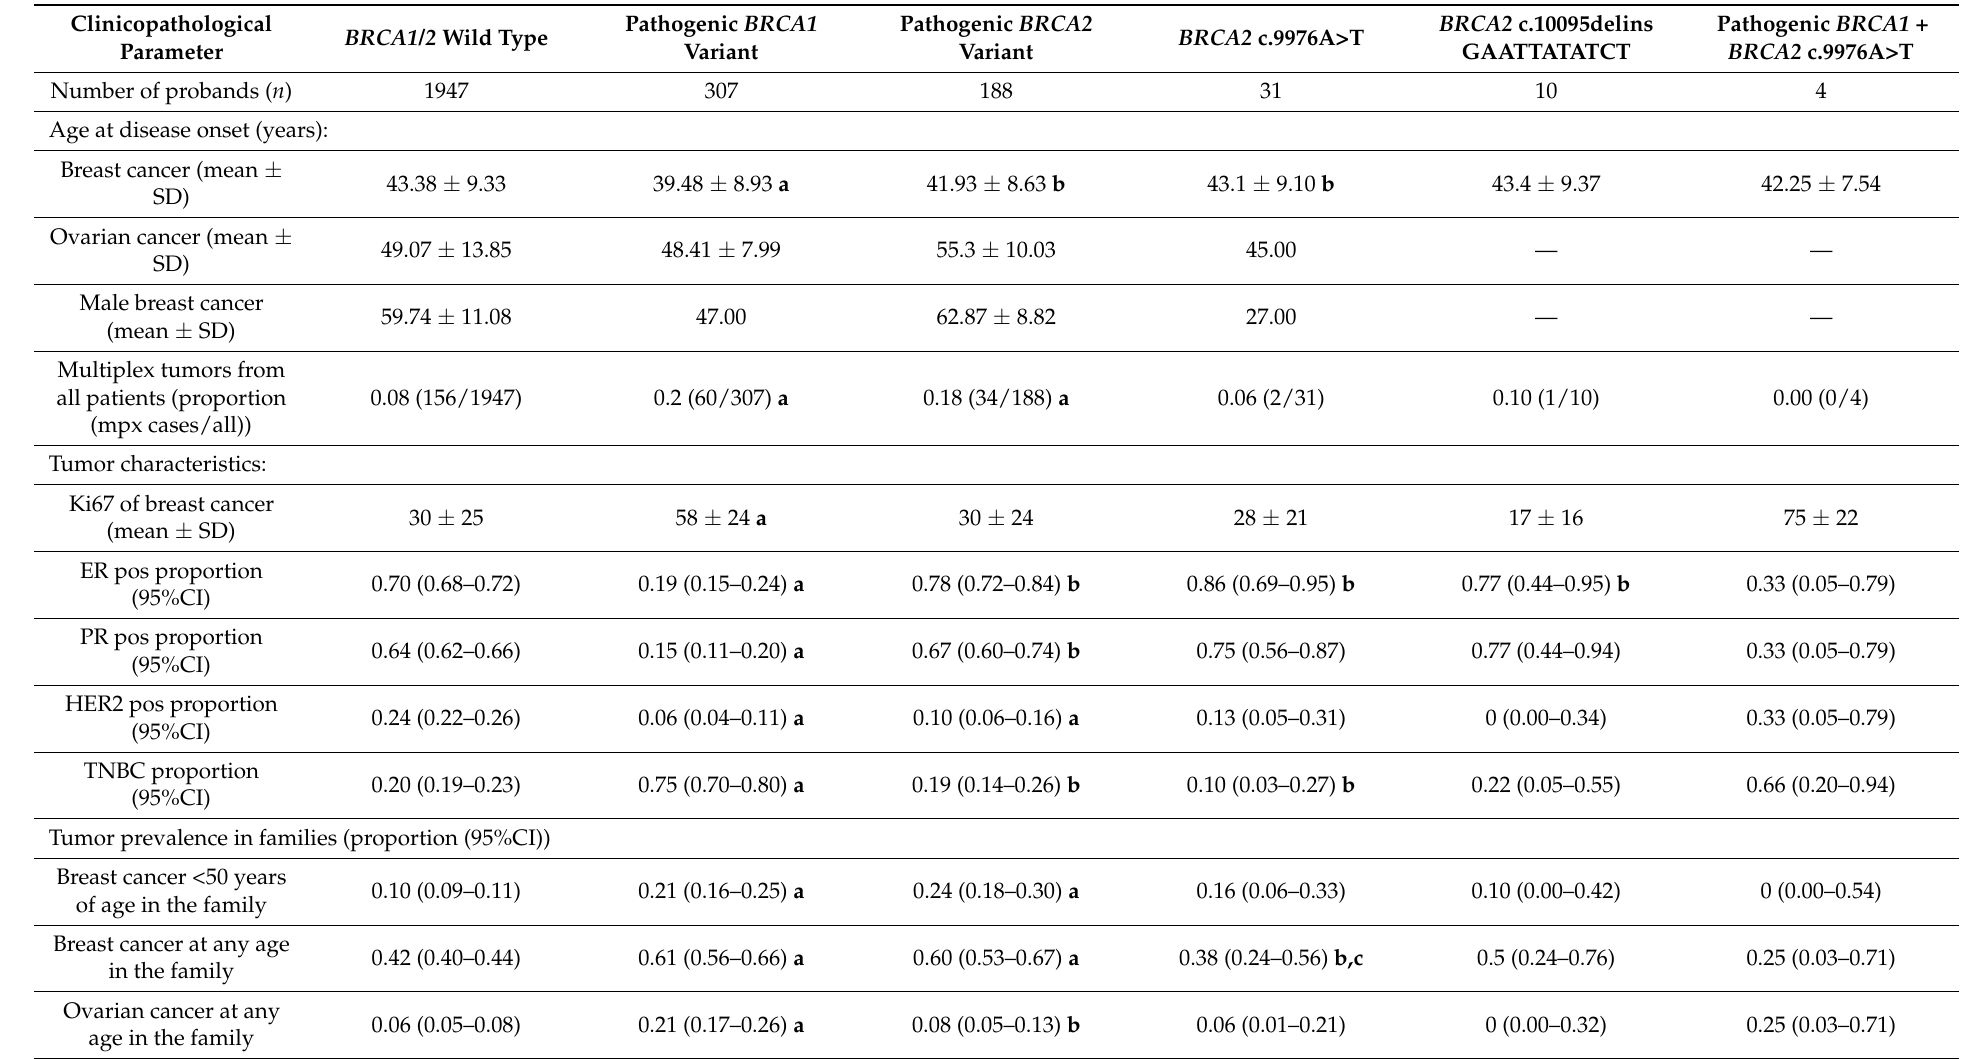
Table 2. Cancer prevalence and tumor characteristics in hereditary breast and ovarian cancer (HBOC) probands and their families (proportions with ±